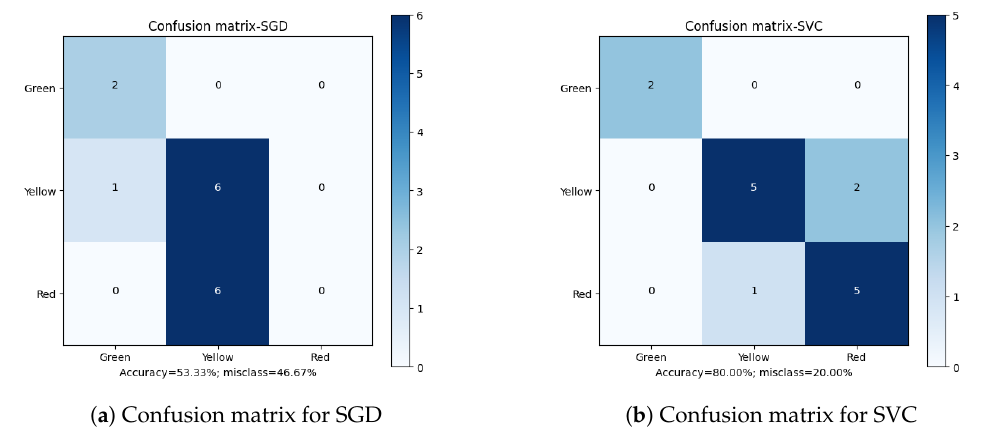
Figure 14. Confusion matrices for Stochastic Gradient Descent and Support Vector Machine classifiers. What is most important is the lack of “Green-Red” and “Red-Green” errors in the